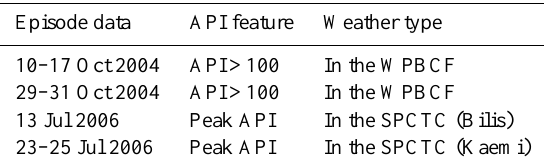
Table 1. Weather types of pollution episodes during the observation